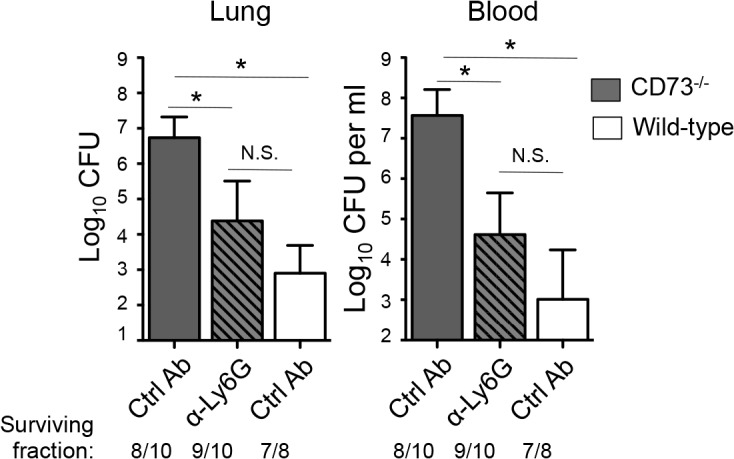
Post-infection depletion of PMNs partially reverses the susceptibility of CD73
-/- mice to pneumococcal challenge.
CD73
-/- mice were treated with anti-Ly6G antibodies 18 hours after I.T inoculation of 5x103 CFU of S. pneumoniae TIGR4. Three days after infection, bacterial burdens in the lungs and blood were compared to those of isotype control antibody-treated CD73
-/- and wildtype mice. Pooled data from three separate experiments (n = 7 mice per group) are shown. Data represent means +/- SEM and significant (p<0.05) differences, determined by student’s t-test, are indicated by asterisk. Below the graphs are indicated the fraction of surviving mice within each group.